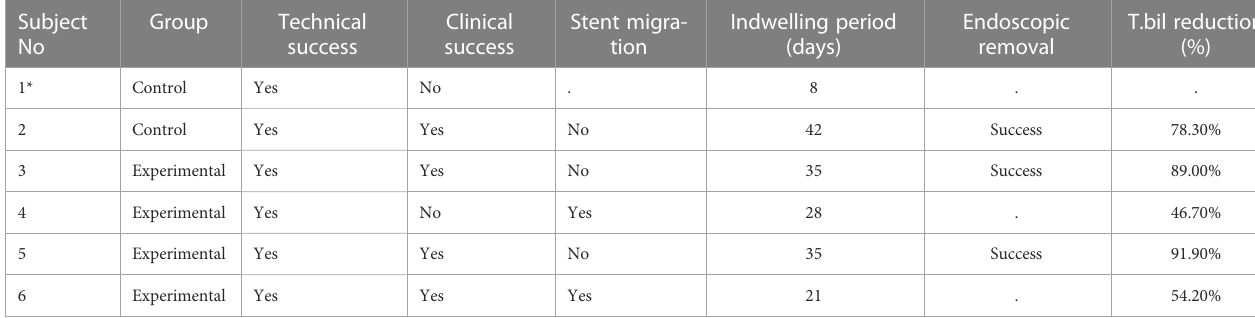
TABLE 1 Characteristics of all subjects that underwent endoscopic stent deployment.